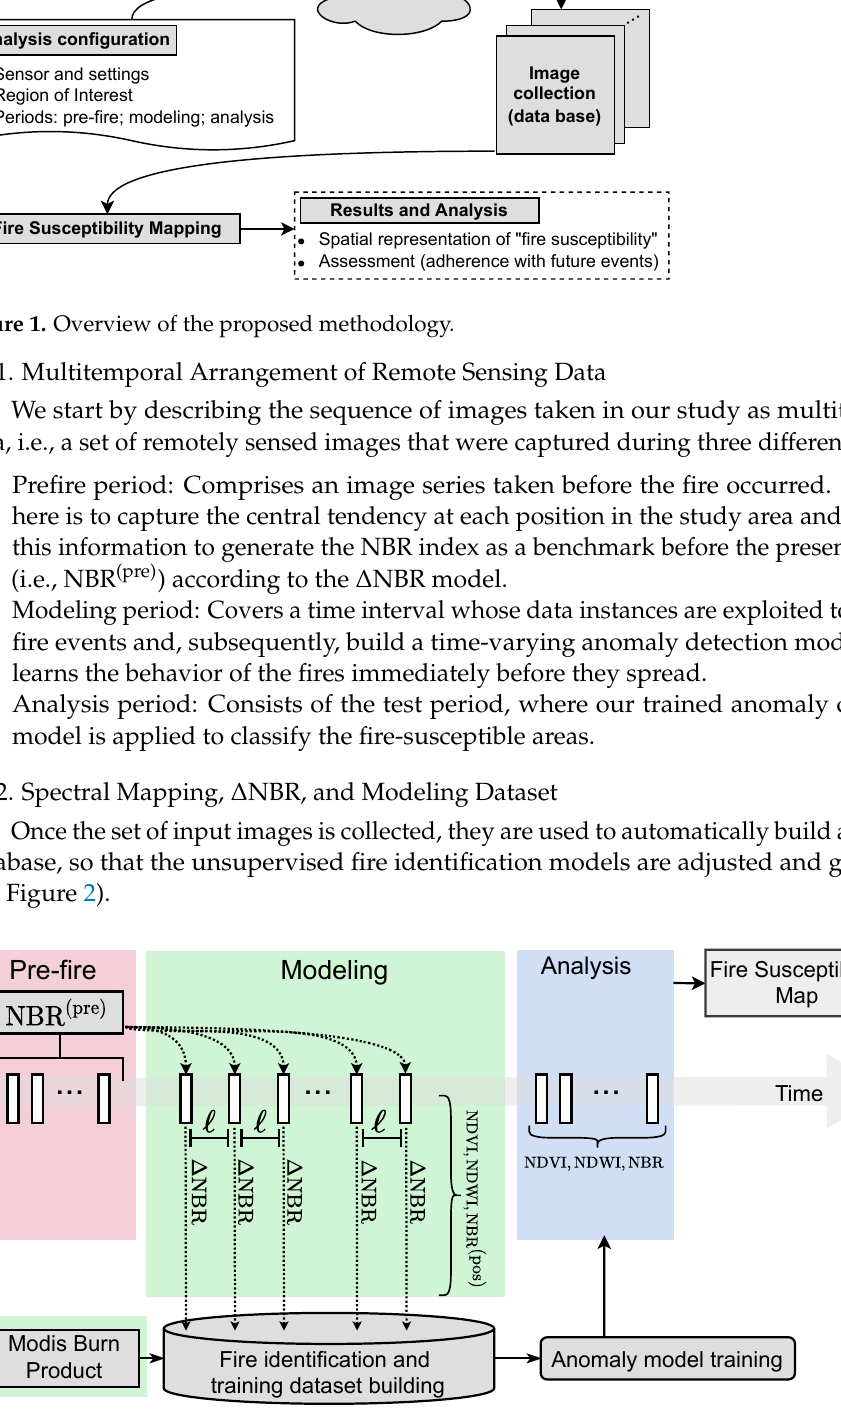
Figure 2. Step diagram of the proposed methodology for mapping fire